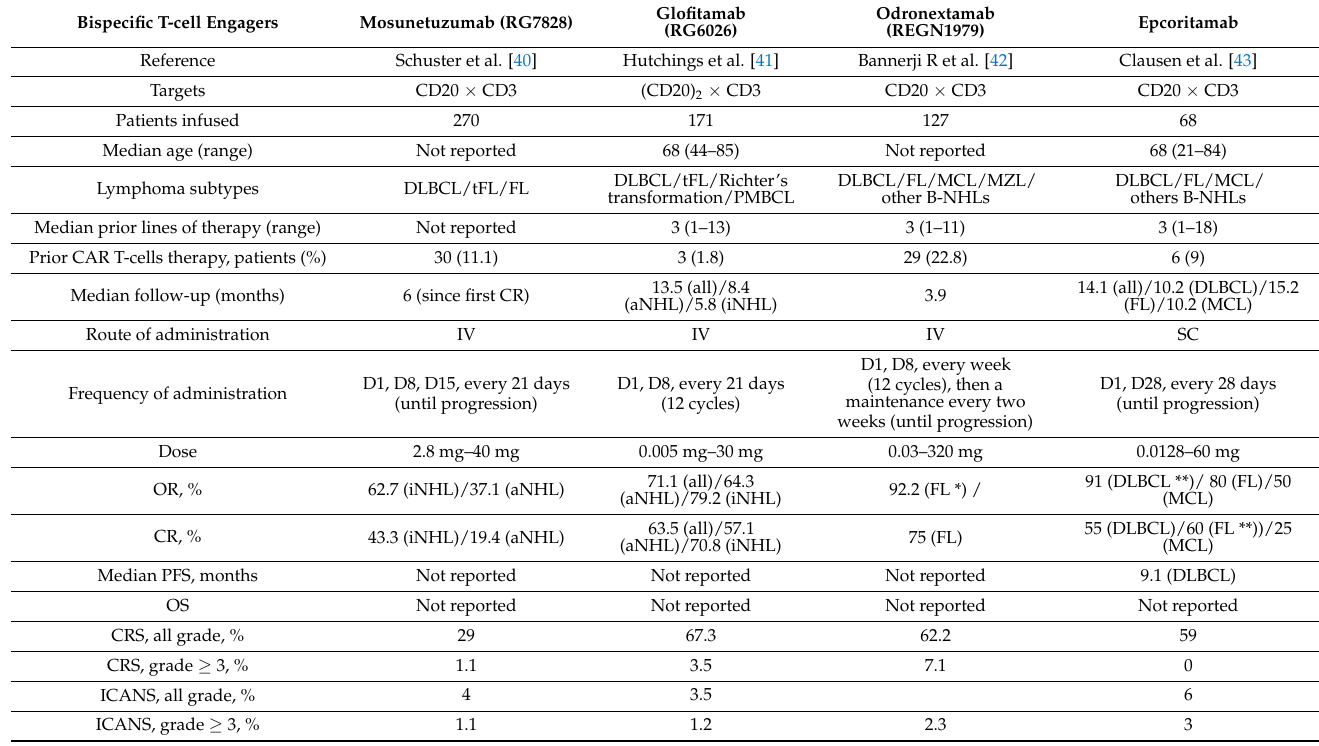
Table 5. Main Bispecific T-cell